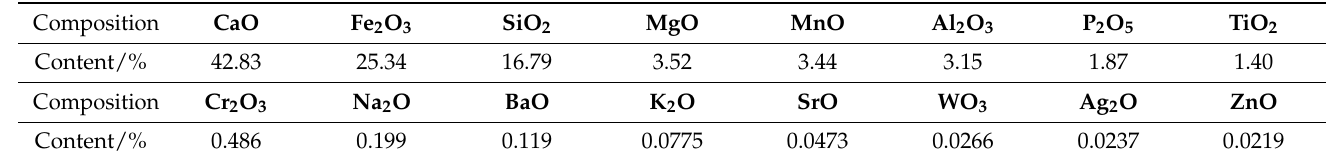
Table 2. Chemical composition analysis of steel slag.